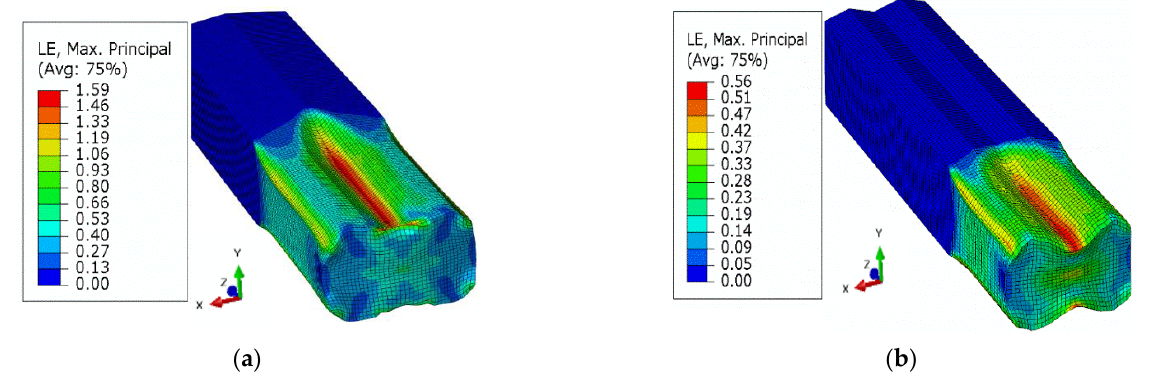
Figure 18. Maximum principal logarithmic strain distribution: ( a ) single barrel, ( b ) double barrel.